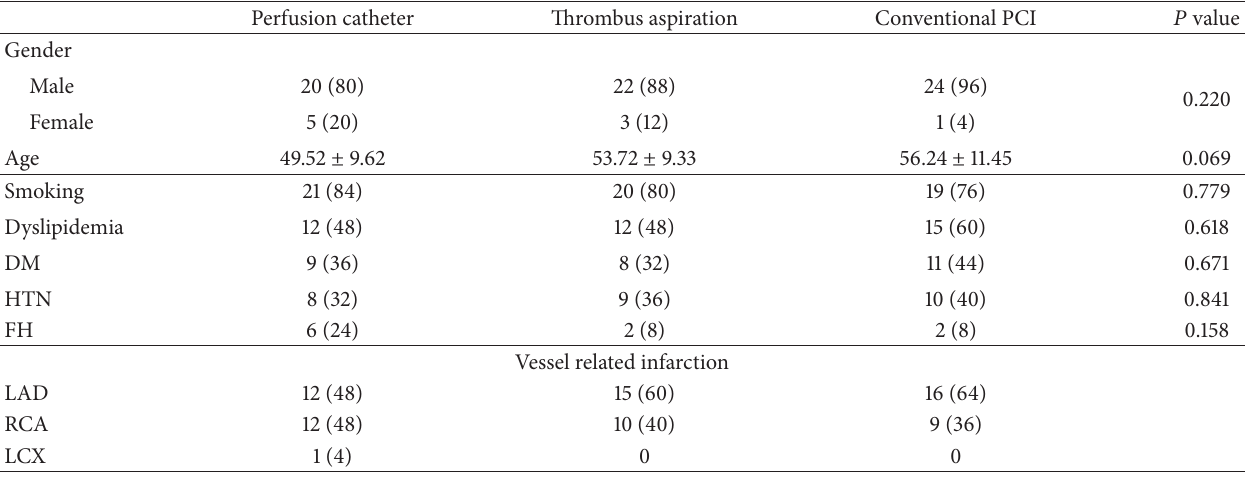
Table 1: Baseline demographic data in the three groups.